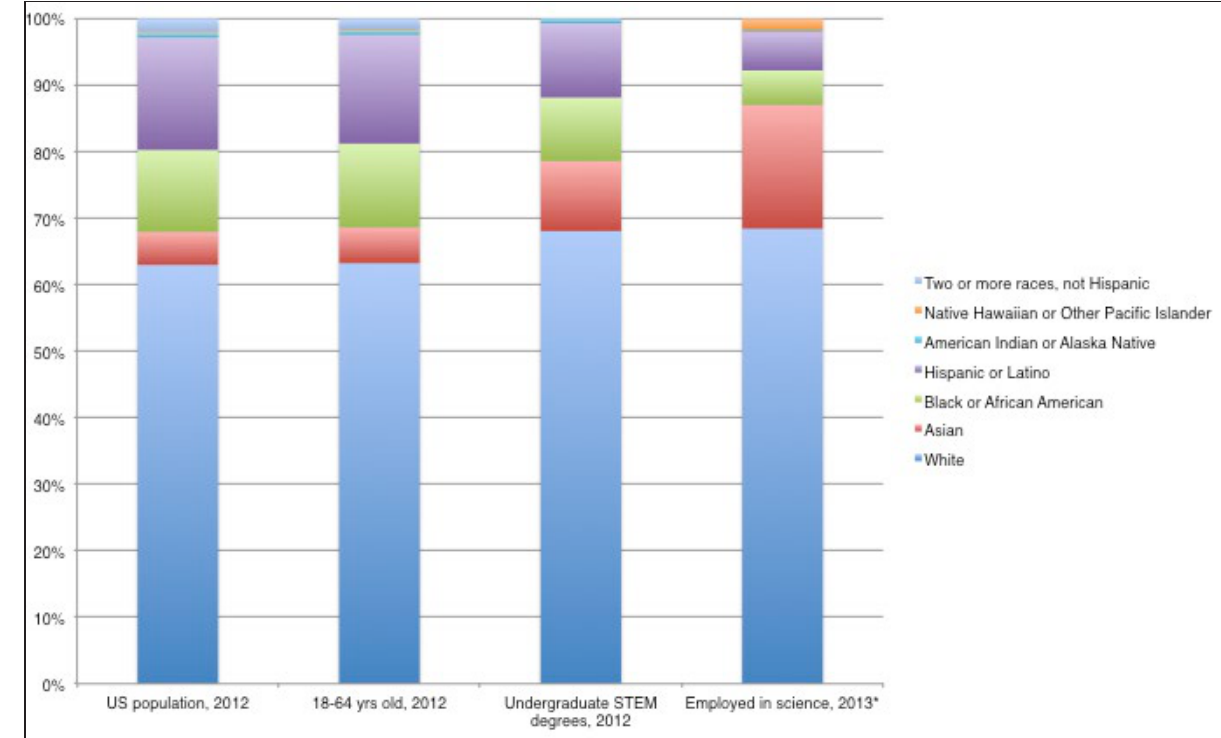
Figure 3: Demographic profile of US total and employment-aged population, STEM undergraduate degrees, and those with employment in